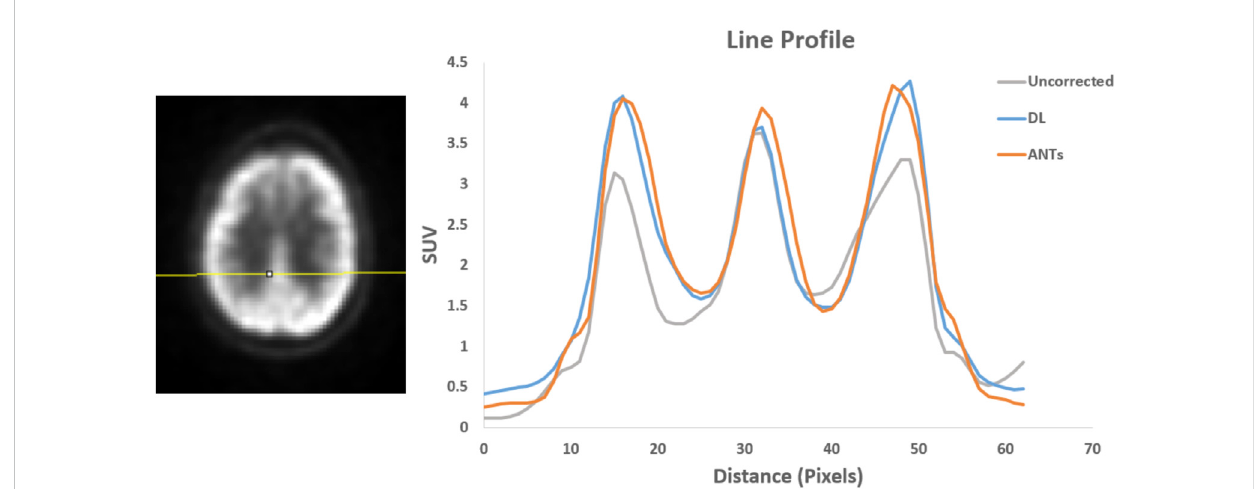
FIGURE 8 Patient Study 2: A region in the brain area (left) where a line pro fi le (right) was manually drawn. The peak-to-valley ratio for the motion-corrected data with the deep learning (DL) approach is close to the ANTs method.